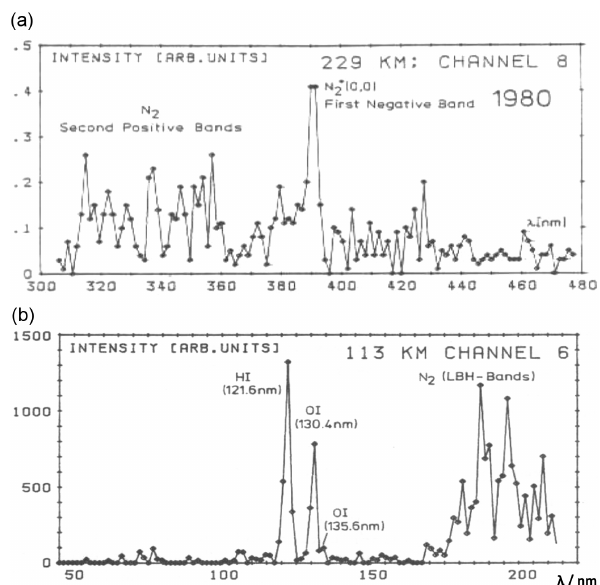
Figure 27. (a) Emission spectrum of an oscillating diffuse aurora between 300 and 480nm on 16 November 1980 over Kiruna, Swe- den. Intensity is in arbitrary units (Schmidtke et al., 1983; copyright permission granted by Elsevier publishing). (b) Emission spec- trum of an oscillating diffuse aurora between 50 and 200nm on 16 November 1980 over Kiruna, Sweden. Intensity is in arbitrary units (Schmidtke et al., 1983; copyright permission granted by Elsevier publishing).